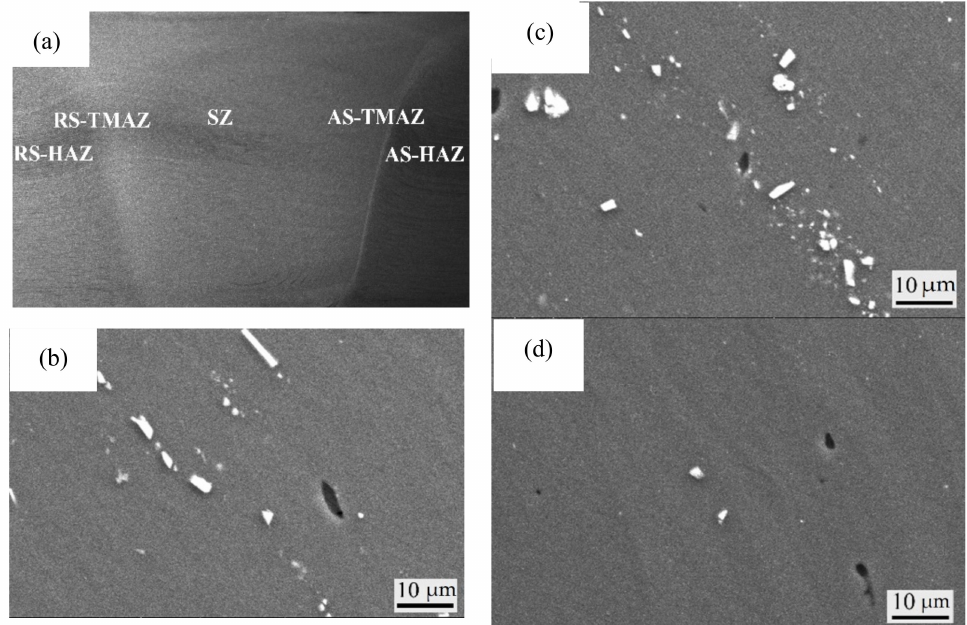
Figure 1. The second phase particles of 7A52 aluminum alloy FSW joint: ( a ) The cross section of the 7A52 aluminum alloy FSW joint; ( b ) AS-TMAZ; ( c ) SZ; ( d ) S-TMAZ 7A52 aluminum alloy FSW joint fracture